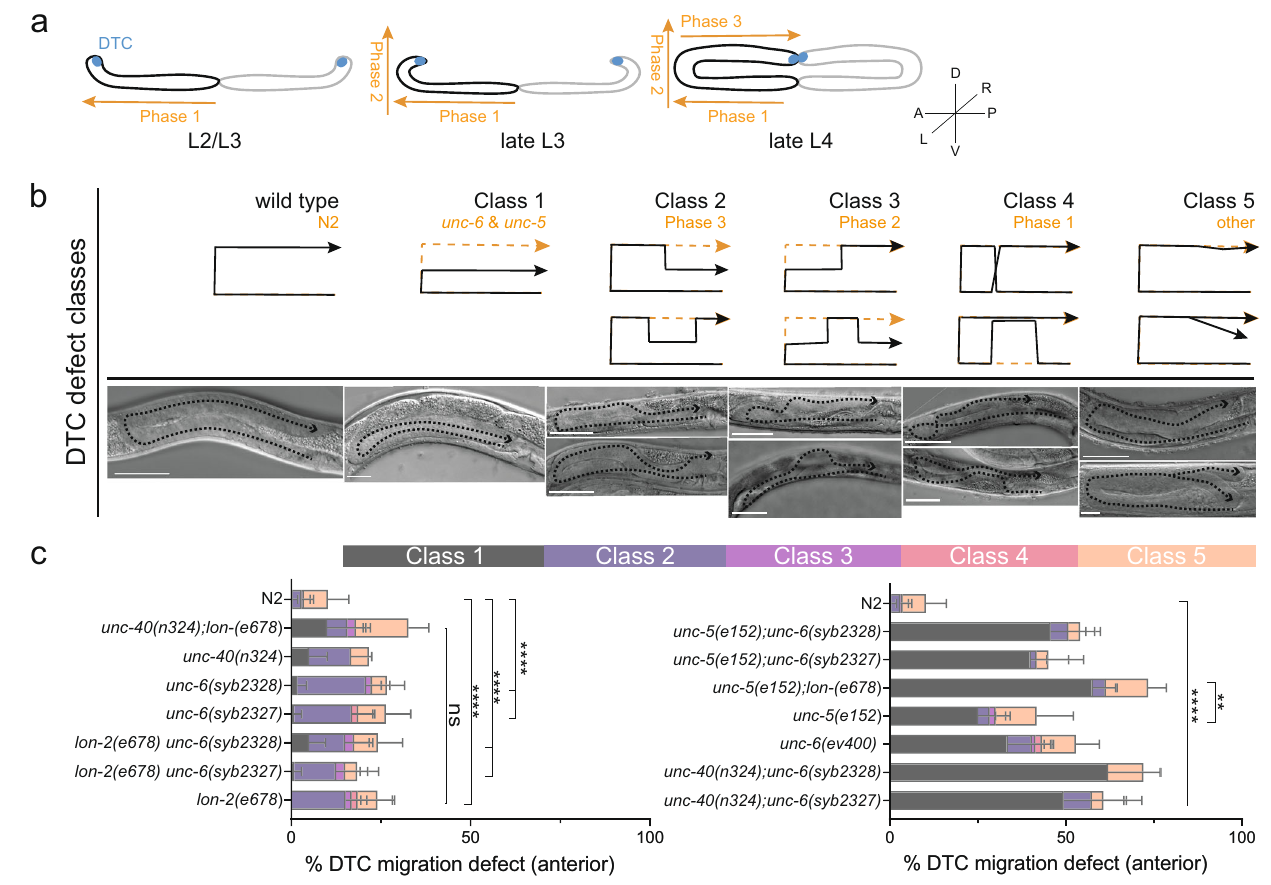
Fig. 7 | Physiological relevance of the NET1 Δ C-GAG interaction in the model system C. elegans (part 1). a Schematic representation of post-embryonic her- maphrodite gonad development. Phase 1 migration begins along the ante- roposterior (AP) axes followed by phase 2 leading the gonad arm along the dorsoventral (DV) axes. Phase 3 represents cessation of migration. Leading distal tip cells (DTC) are indicated in blue. b Representative Differential Interference Contrast (DIC) micrograph of gonad arms of L4 stage wild type animals in lateral view ( fi rst panel). Class 1 represents the classic unc-5/unc-6 defect, classes 2 – 4 frequently observed defects during the indicated phase, class 5 mild or defects